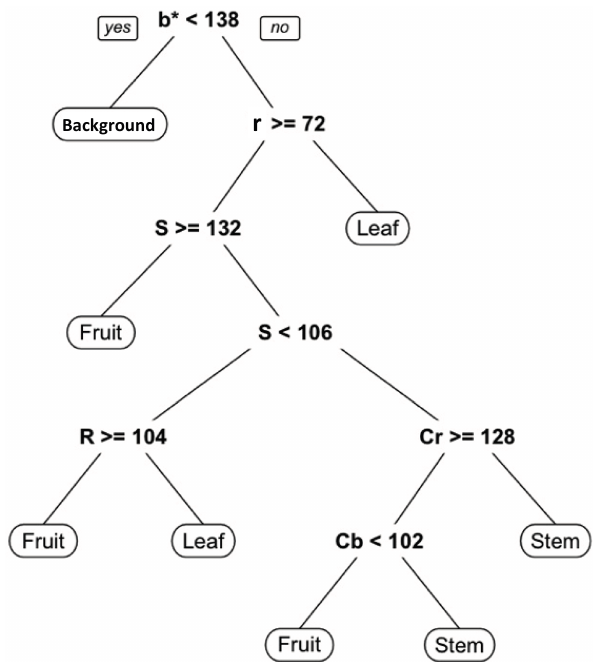
Figure 5. Generated decision tree for pixel-based segmentation.